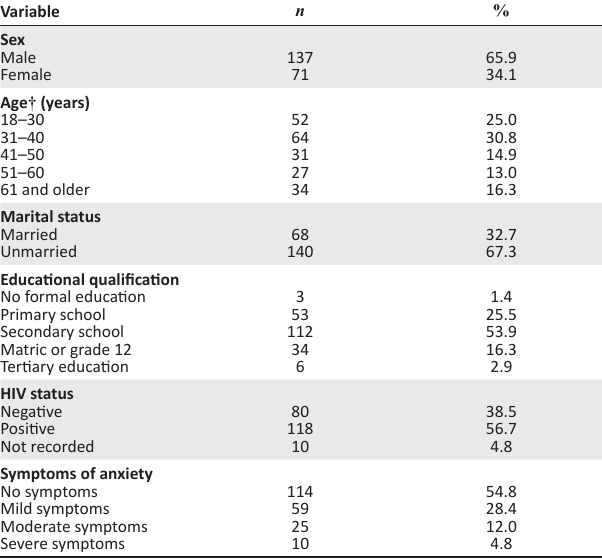
TABLE 1: Participants’ characteristics ( N = 208).